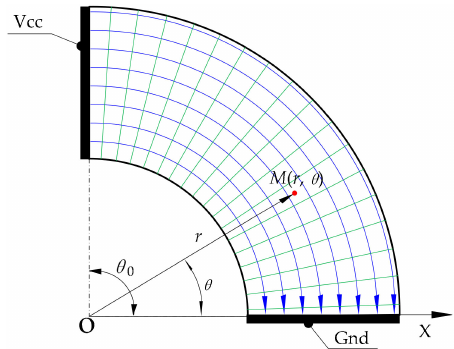
Figure 6. Diagram of electric field distribution in the detection of the polar angle.